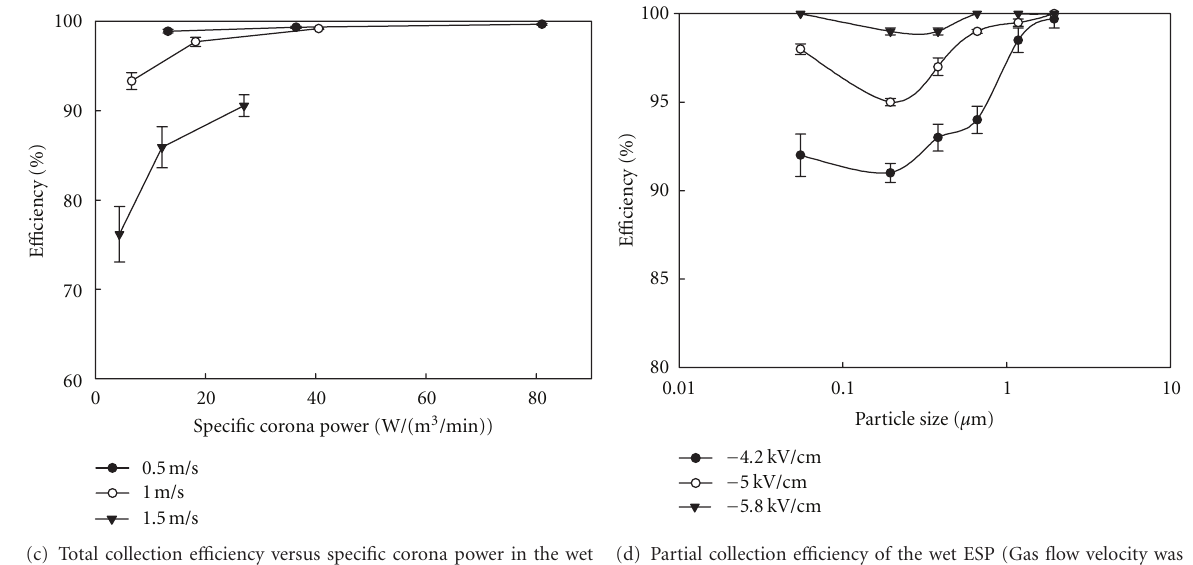
Figure 6: Comparison of particle collection e ffi ciency in terms of the interactive relationship between particle size and key operation variables (i.e., electrical field, SCA, and specific corona